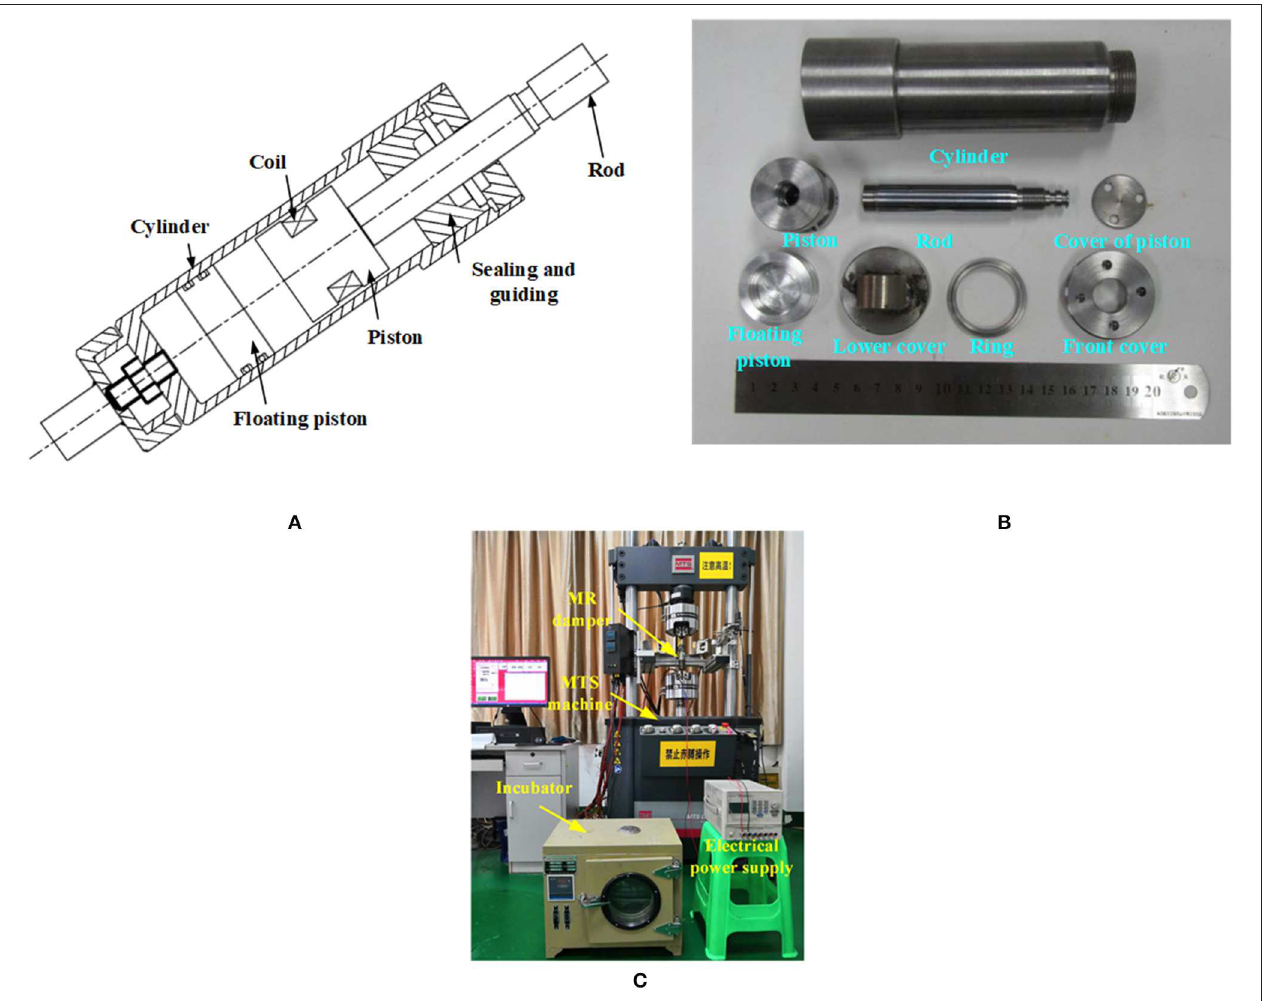
FIGURE 1 | Experimental test of MR damper with accumulator: (A) diagram of MR damper, (B) picture of MR damper, and (C) picture of test